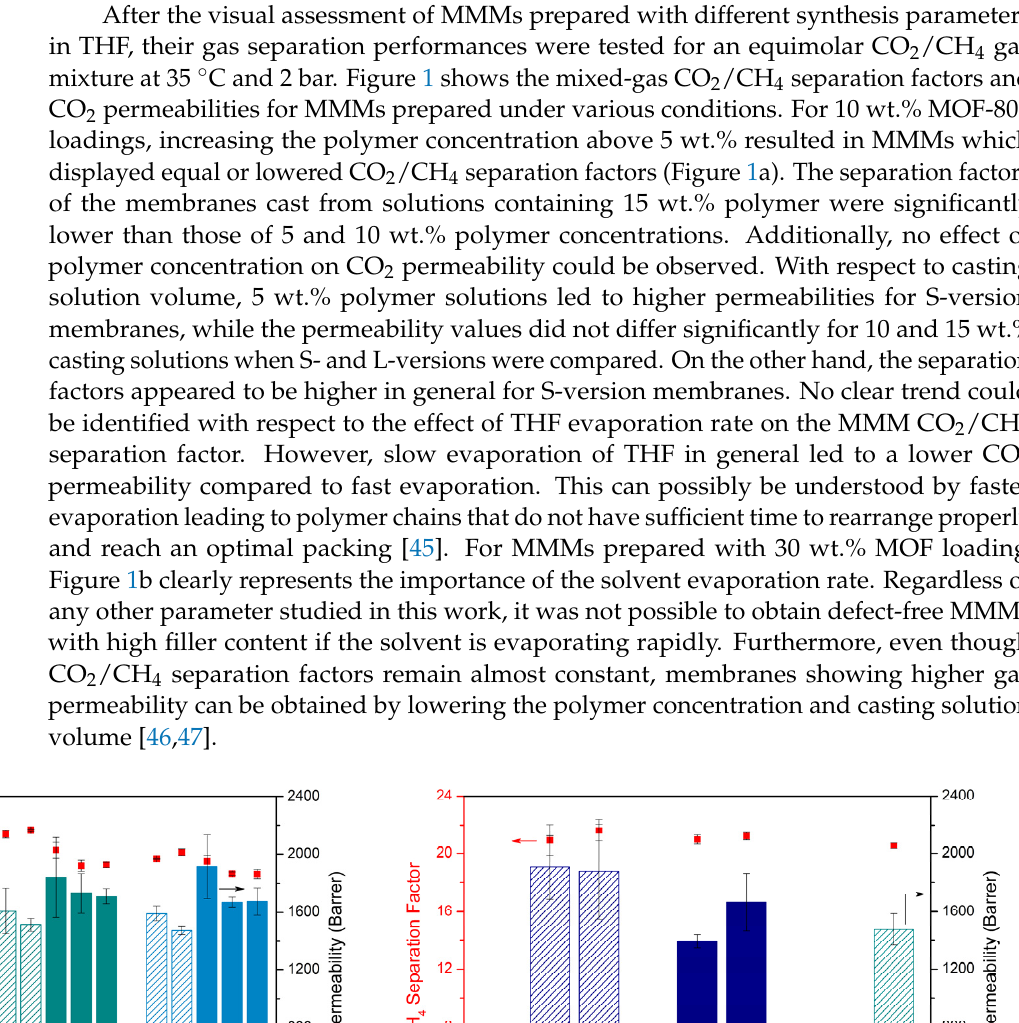
( c ) Figure 2. Mixed-gas CO 2 /CH 4 separation factors (dots) and CO 2 permeabilities (bars) of unfilled 6FDD membranes and corresponding MMMs cast from ( a ) 5 wt.%, ( b ) 10 wt.%, or ( c ) 15 wt.% pol- ymer solutions with different combinations of synthesis parameters. “PX” represents the polymer concentration of the solutions while “S” and “L” indicate the small and large solution volume, re- spectively. “MX” corresponds to the amount of MOF loading (wt.%). In general, slight decreases can be observed in the separation factors of the mem- branes upon MOF incorporation, while permeabilities increased significantly. The change in casting solution polymer concentration had no significant impact on the performance of the unfilled polymeric membranes, whereas the casting solution volume influenced their performance adversely with increasing volume. For the performance of MMMs, however, low polymer concentration and small solution volume led to more favorable results for CO 2 separation, consistent with the results in Figure 1.